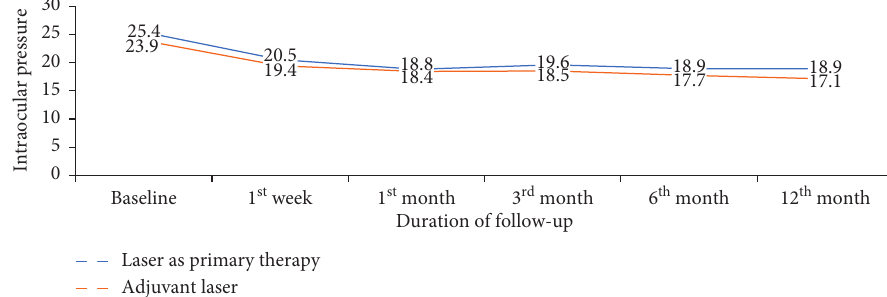
Figure 2: Mean IOP after SLT for laser treatment as primary therapy and adjuvant laser treatment group, Menelik II Hospital, 2018. Table 2: Mean baseline IOP in mmHg and mean IOP reduction in mmHg at the follow-up visit in POAG, PXG, and OHT, Menelik II Hospital, 2018.